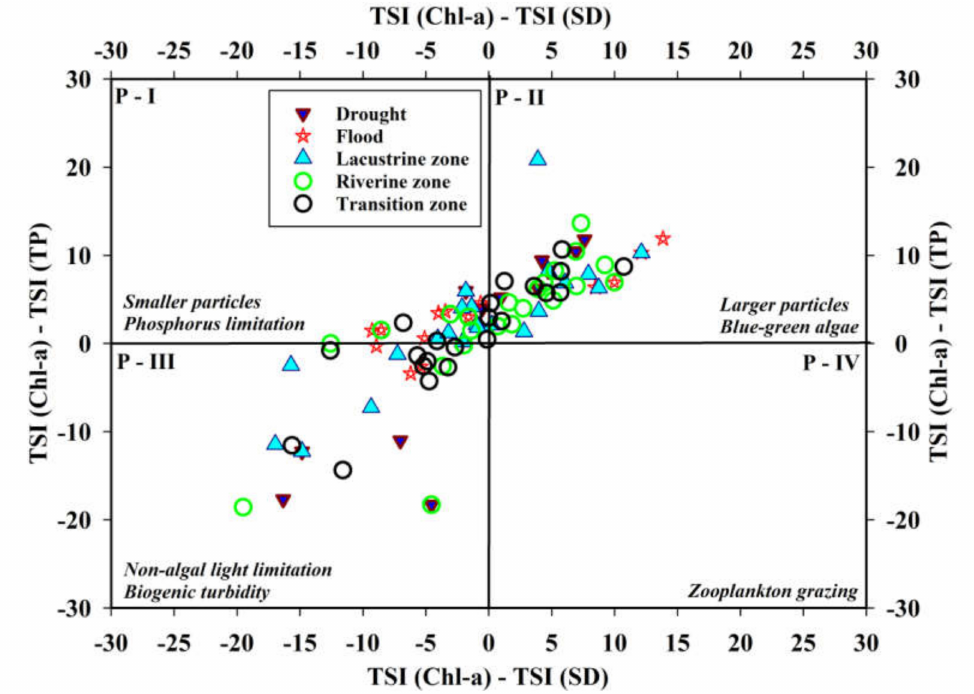
Figure 9. Trophic state index deviation graphical display during flood and drought conditions and in di ff erent reservoir